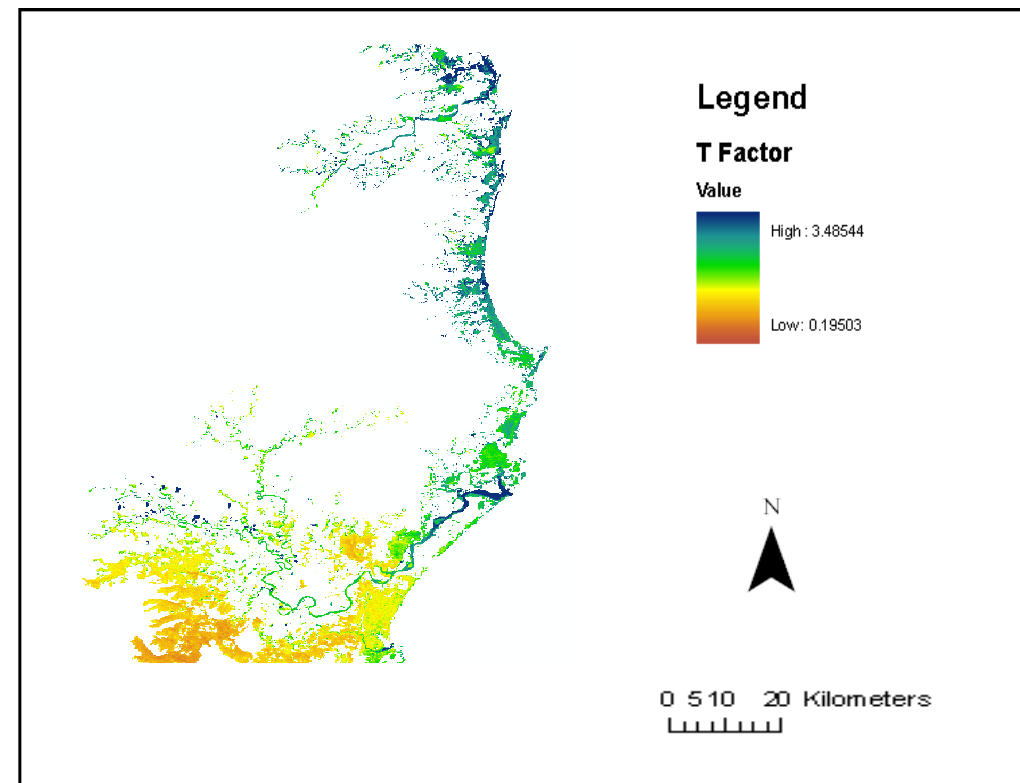
The maximum T factor values (Figure 7) were found in estuarine water bodies, while forested wetlands had the minimum T factor values. Figure 7. T Factor values for the wetland